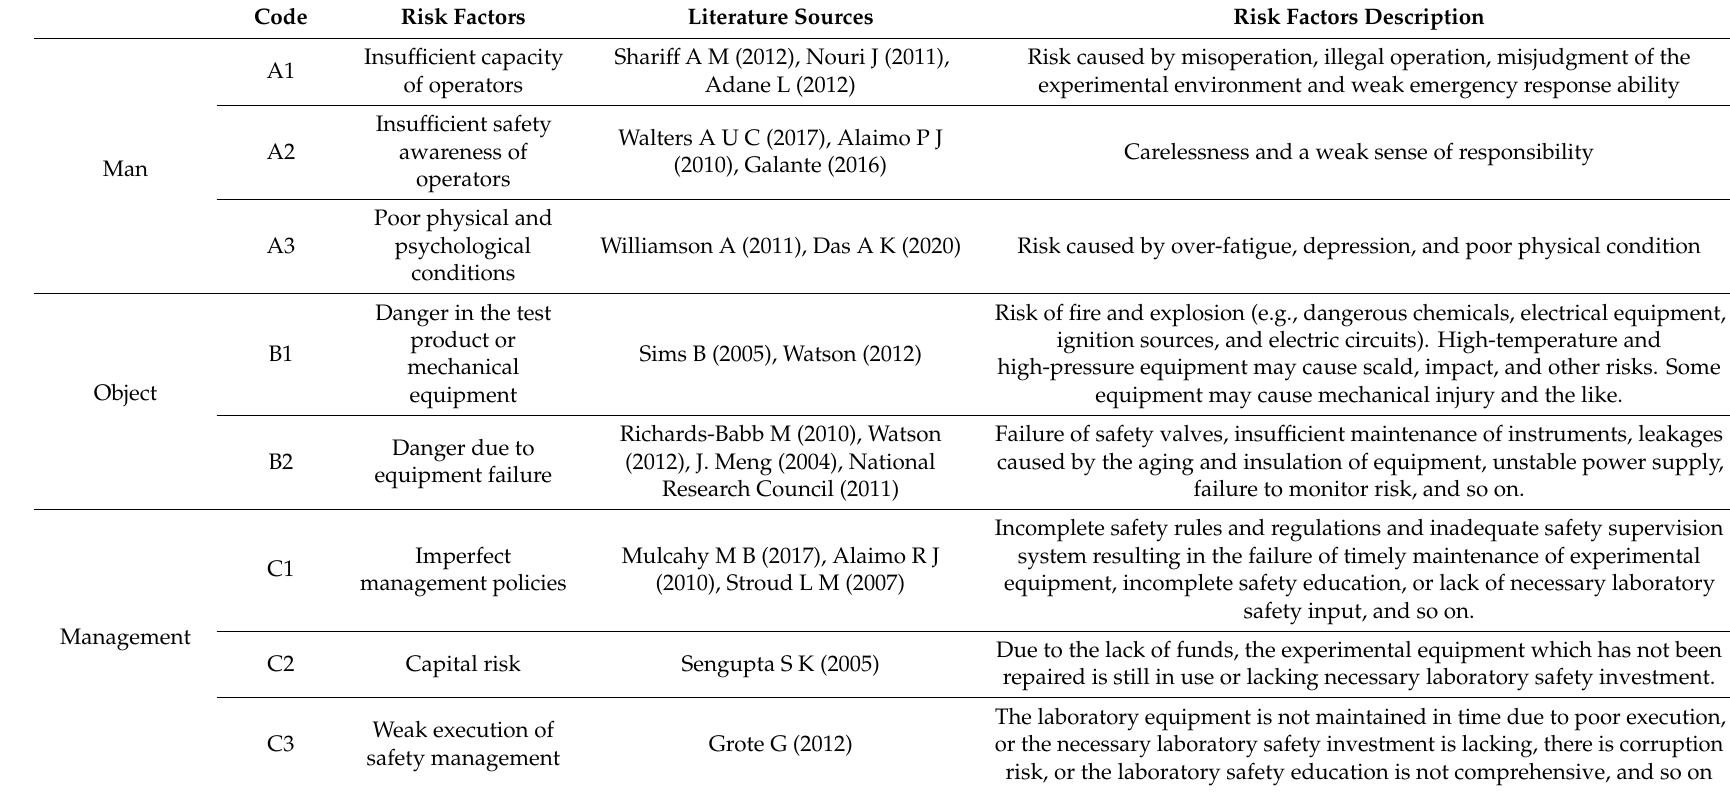
Table 1. Risk factors in civil engineering